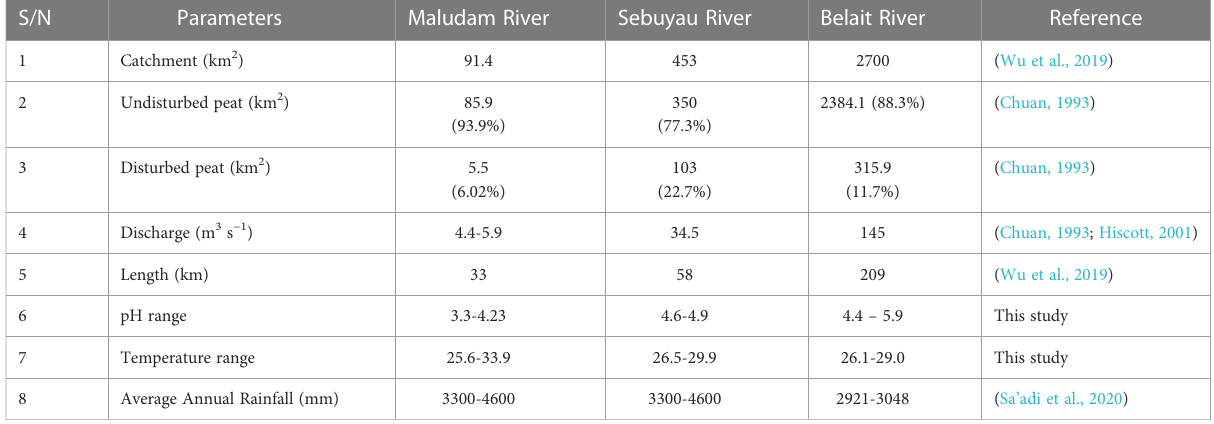
TABLE 1 Hydrographic and catchment description of selected Rivers on Borneo